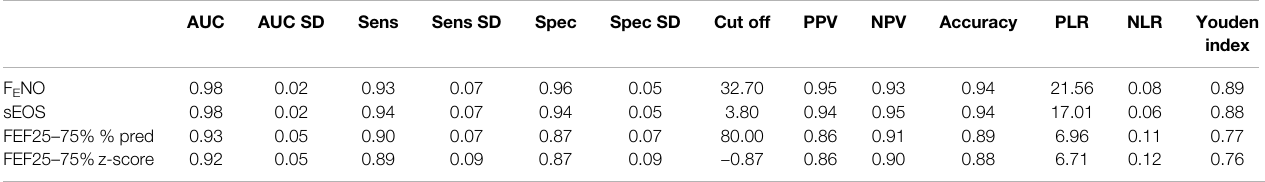
TABLE 2 | BHR predictive accuracies of F E NO measurement, percentage of sputum eosinophil cell counts, FEF 25% – 75% of predicted value, and FEF 25% – 75% z-score in 310 subjects with suspected cough variant asthma. a